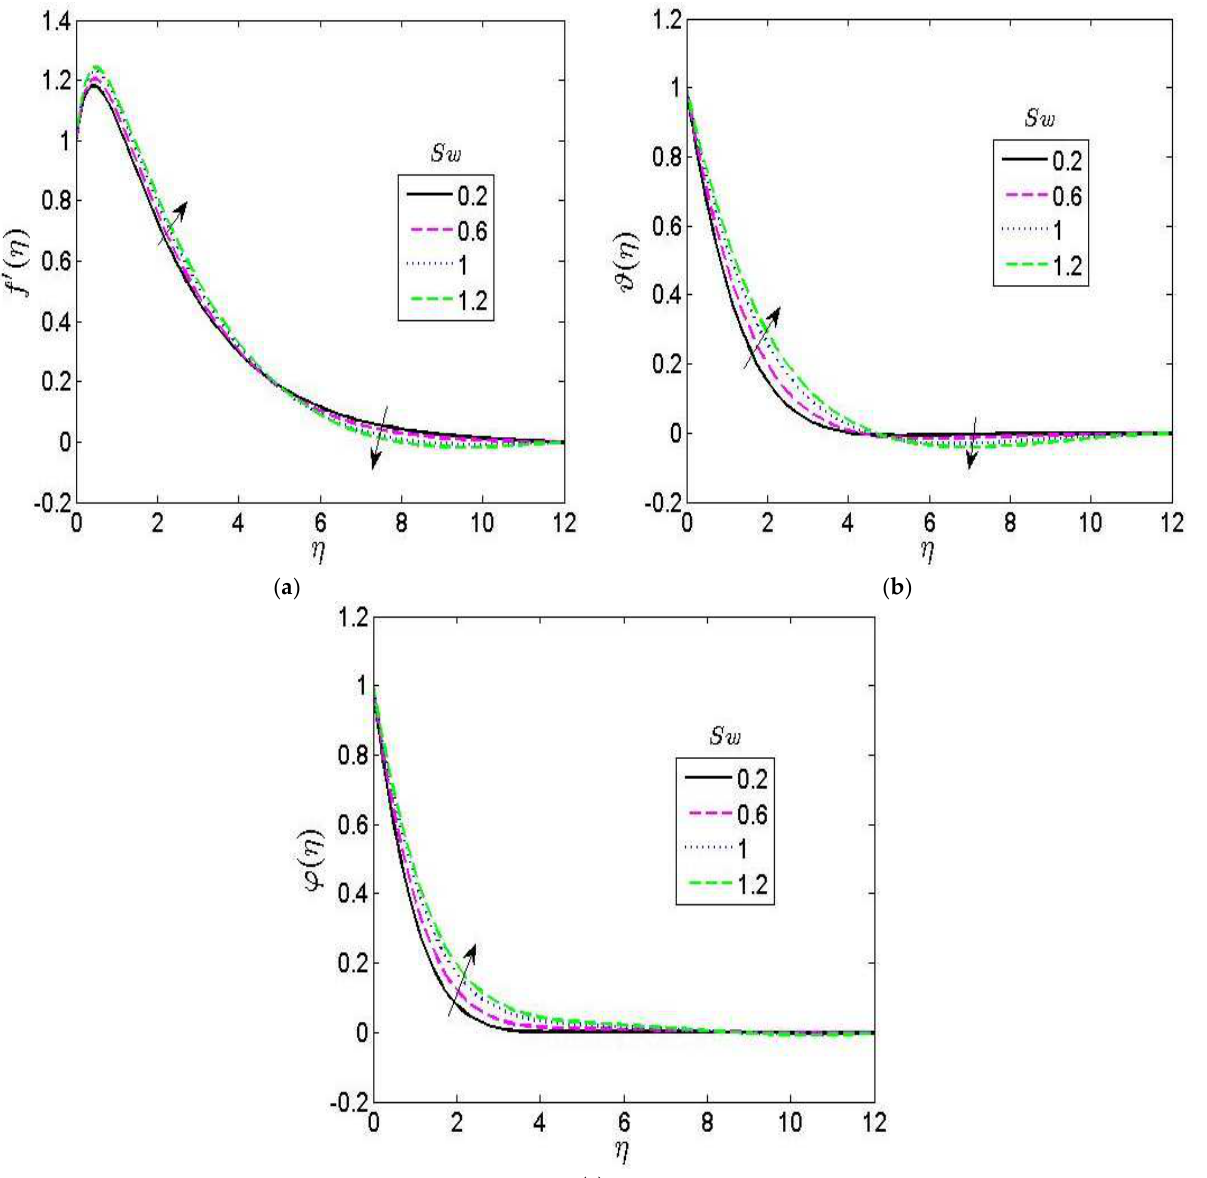
Figure 7. Effect of suction velocity Sw on ( a ) velocity, ( b ) temperature, and ( c ) concentration profiles.